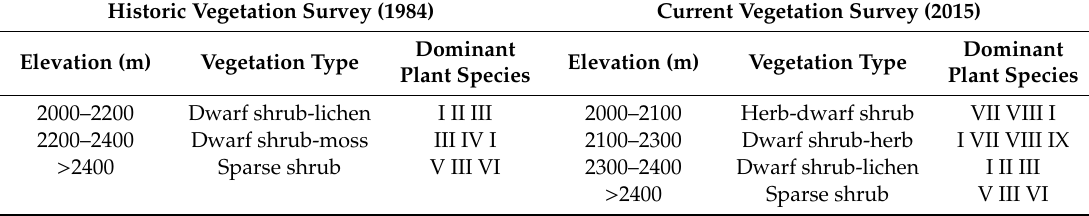
Table 1. The comparisons of vegetation types and plant species along the altitude gradient in the western slope of the Changbai Mountains between historic vegetation survey in 1984 and current vegetation survey in 2015.